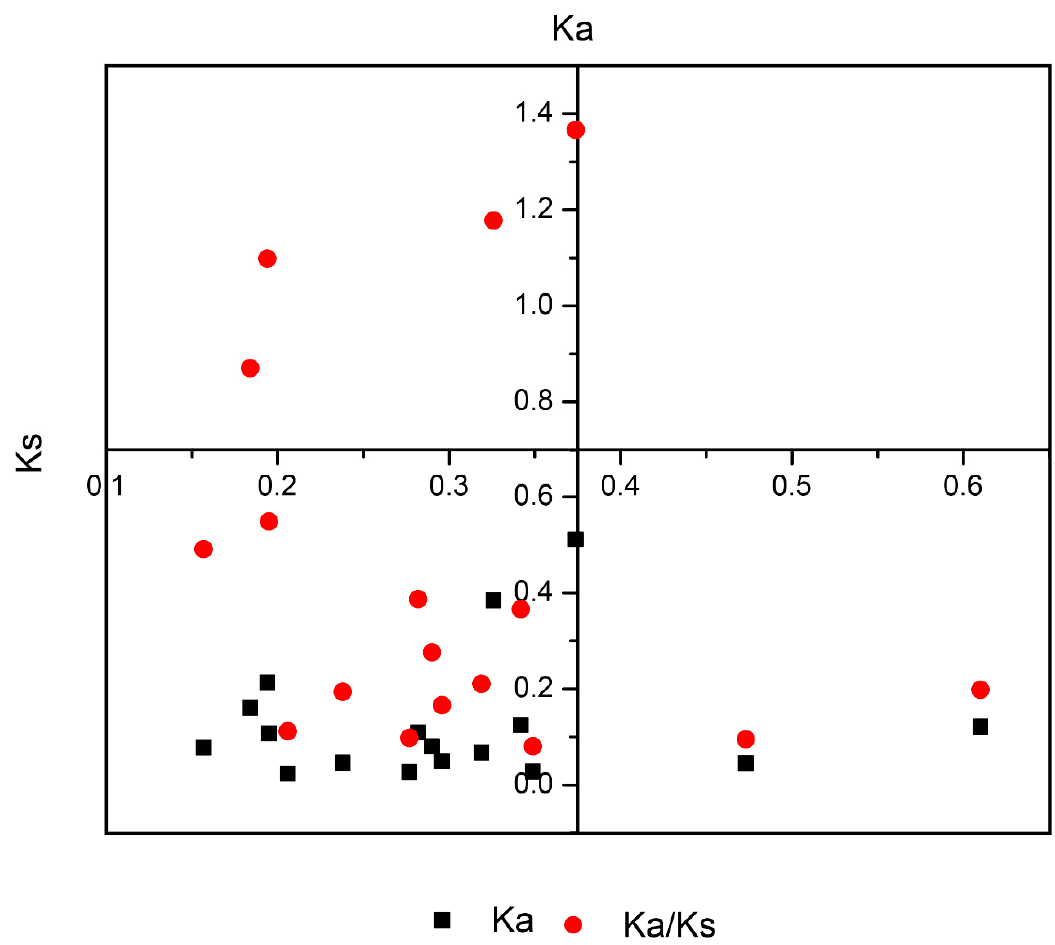
Figure 4. The ratio between Ks and Ka for paralogous gene pairs in Brassica rapa .